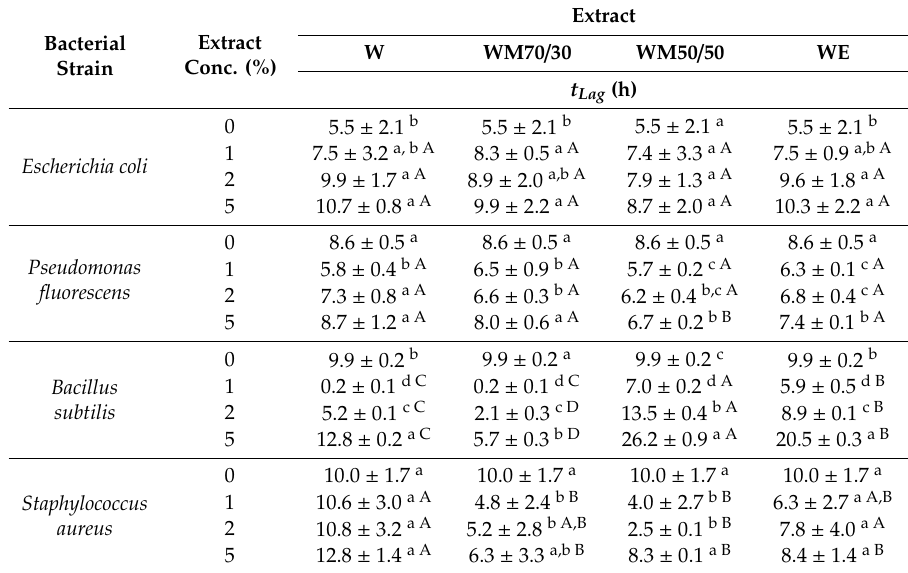
Table 5. E ff ect of chicory root extracts on lag time ( t Lag ) of